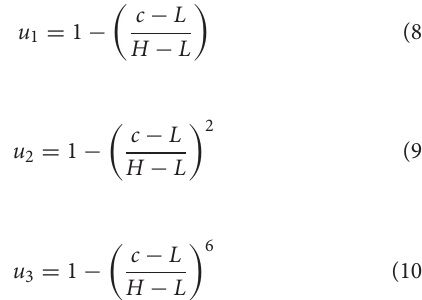
Frontiers in Built Environment |